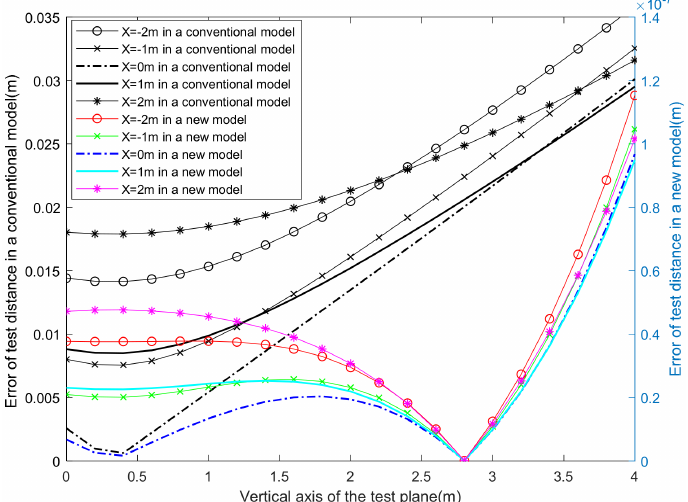
Figure 9. Comparison of test distance errors between traditional and new